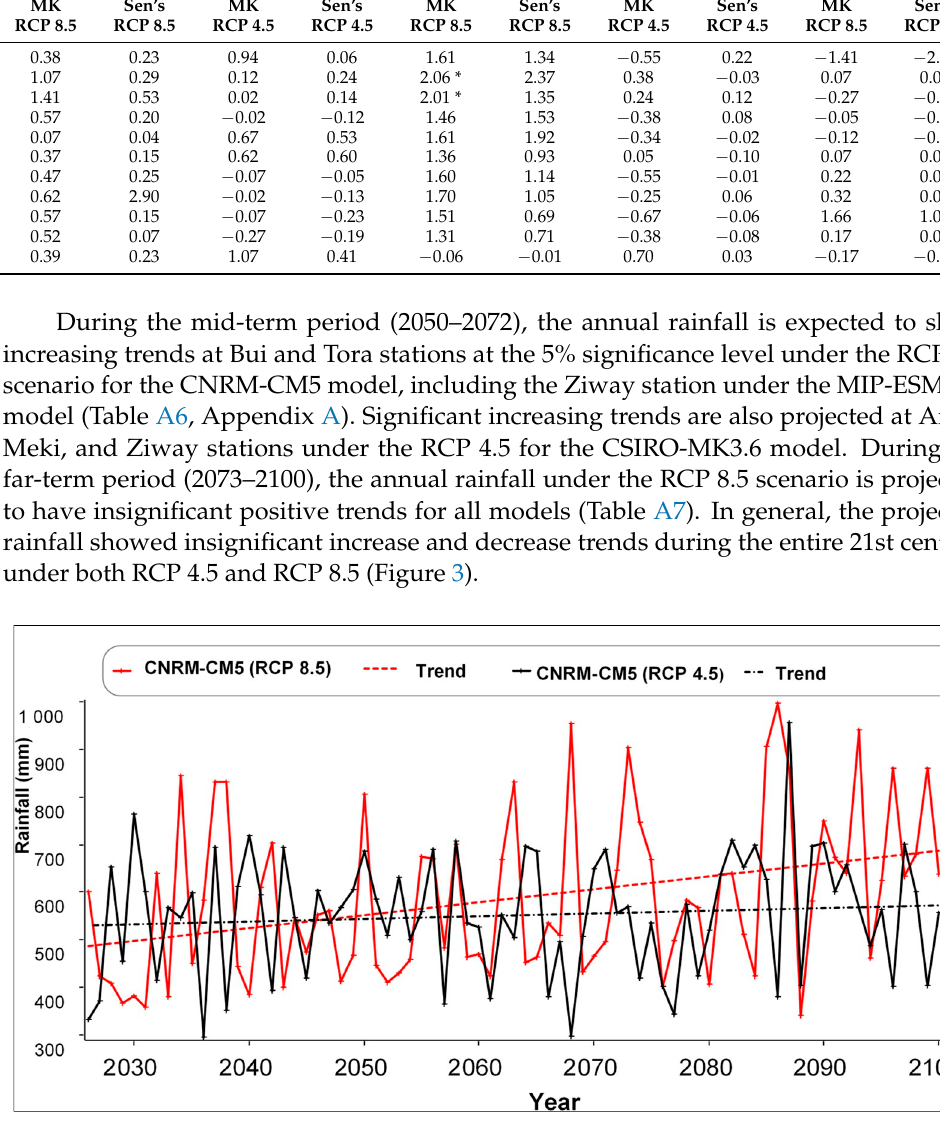
Table 4. Projected Mann–Kendall trend and Sen’s slope estimator results for annual mean T max for eleven stations within the Ziway Lake Basin for the period 2026–2049. Model → 0.02 As shown in Table A8, regardless of the applied scenarios, the mid-term (2050–2072) maximum temperature is expected to be higher than the near-term (2026–2049). In addition, as it should be expected, the RCP 8.5 scenario is projected to cause more warming than the RCP 4.5 scenario by the end of this century (Figure 4). We noticed a significant increasing trend of 0.02 to 0.03 °C/year using the CNRM-CM5 model. The CSIRO-MK3.6 model showed a larger significant increasing rate of 0.08 to 0.09 °C/year within the basin (Table A9). Overall, the annual maximum temperature at the eleven stations of the basin is gen- erally projected to increase at an increasing rate (Figure 4). More importantly, the RCP 8.5 scenario is expected to cause a higher increase in maximum temperature as compared to the RCP 4.5 scenario (Figure 4). This could be due to a continuous increase in radiative forcing emissions under the RCP 8.5 scenario [45].